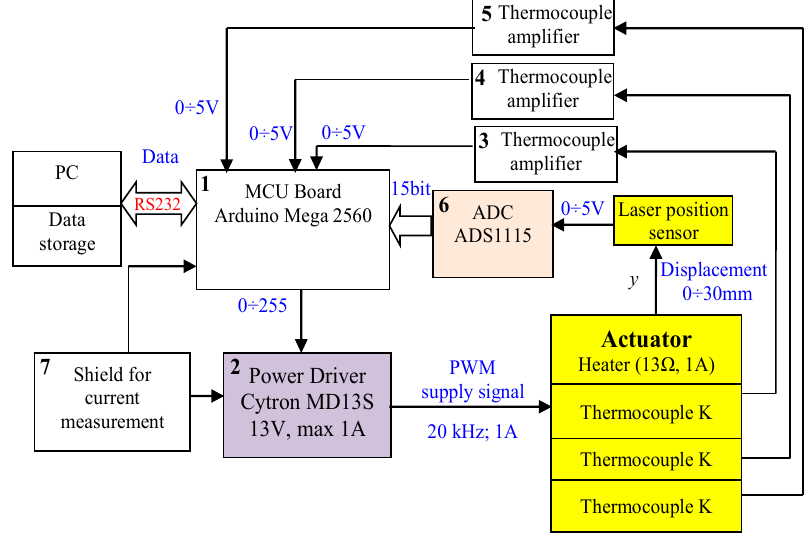
Figure 7. Block scheme of the test stand for distance and temperature measurement.